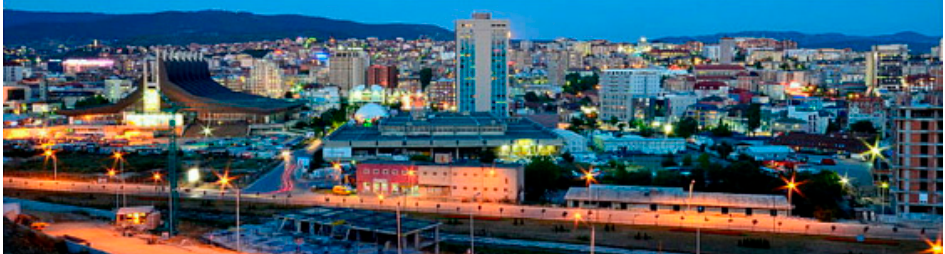
Figure 2. Panoramic view of Pristina, Kosovo. Image courtesy of Kosovo Info.